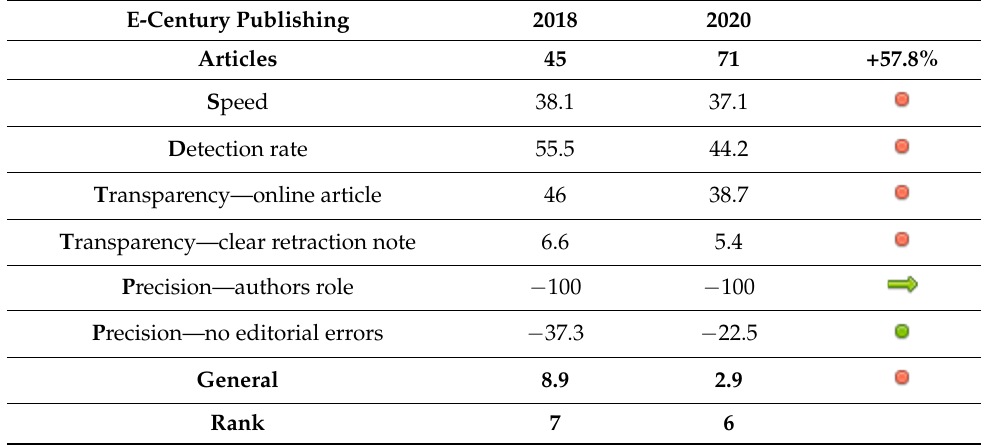
Table 16. Springer Nature 2018 – 2020 change of SDTP score. Table 18. Wiley-Blackwell 2018 – 2020 change of SDTP score.